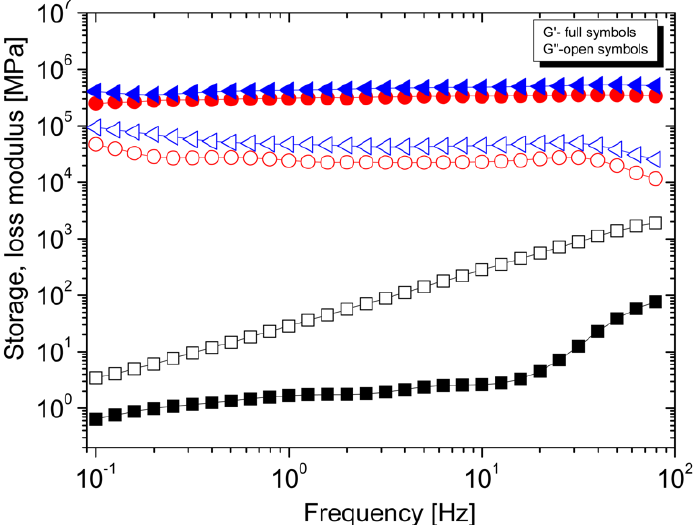
Figure 4. The dependence between storage modulus (full symbols) and loss modulus (open symbols) for neat coPA (black curves), coPA + 5 wt% MWCNTs (red curves) and coPA + 10 wt% MWCNTs (blue curves). Test temperature 180 ° C, strain 0.1%.